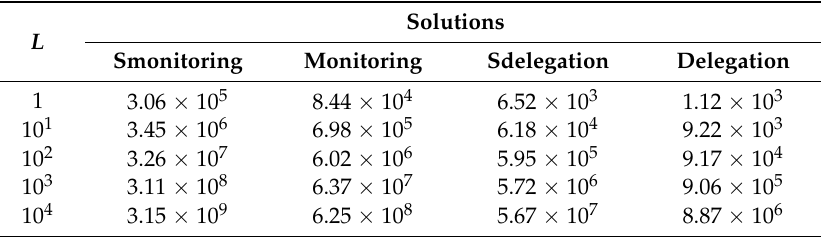
Table 4. Computational cost in Gas for resource